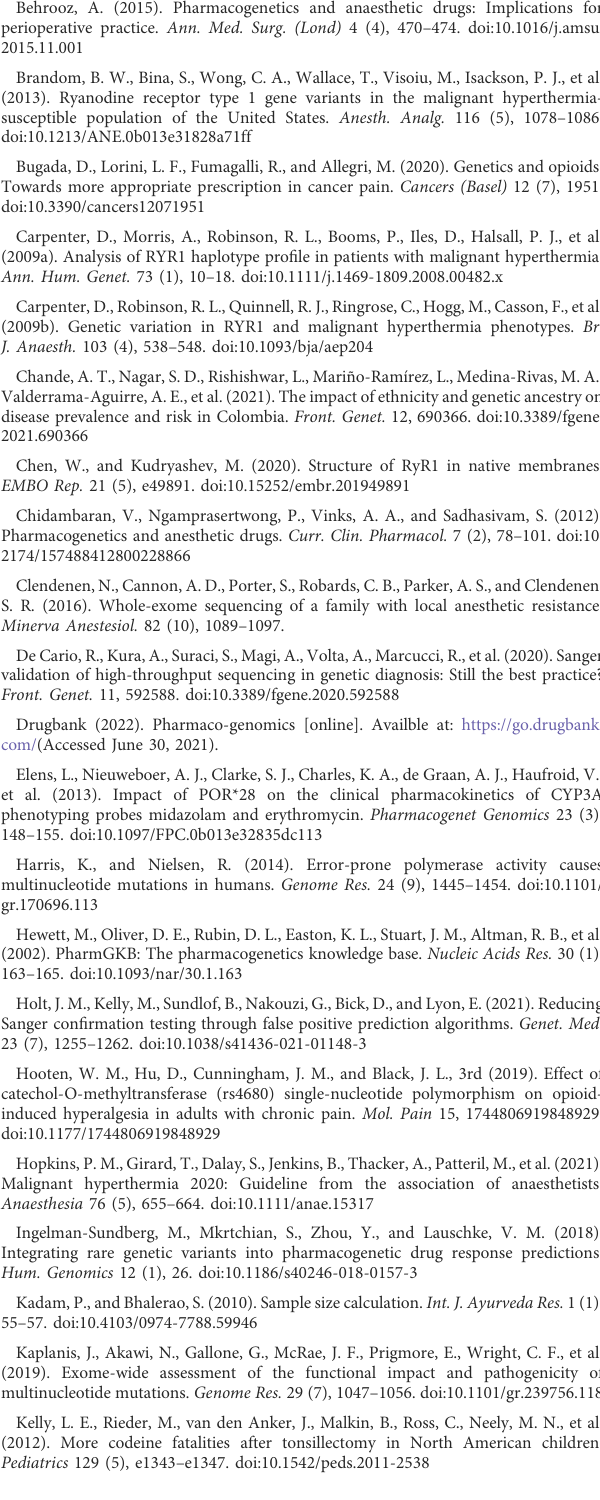
SUPPLEMENTARY FIGURE S1 Multiple-nucleotide variant (MNV) in RYR1 gene. (A) . Sanger sequencing chromatogram showing the RYR1 c. 1026G > T and c.1027A > T genotypes that obtained by cloning approach showing allele carrier of